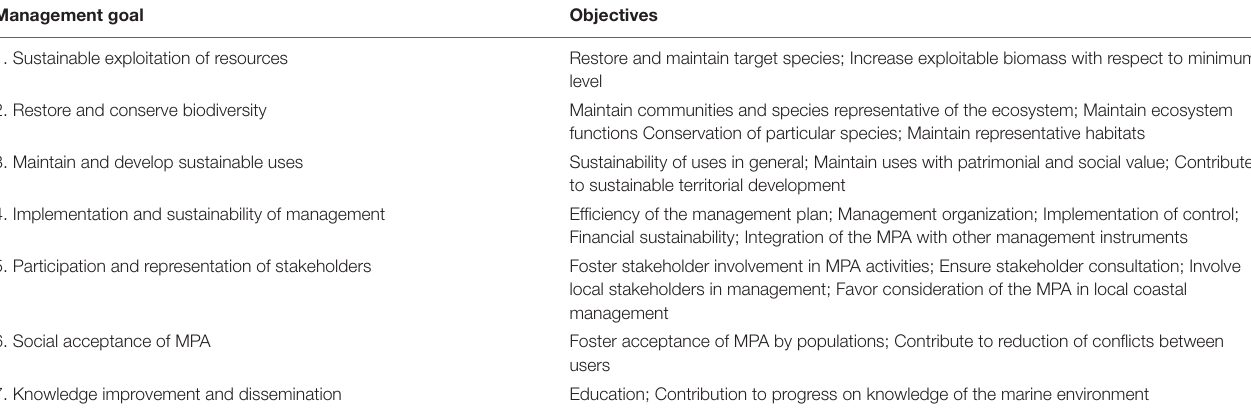
TABLE 1 | Consensus-based formulation of MPA management goals and objectives that laid the foundation for subsequent work on the indicators and decision-support tools. Management